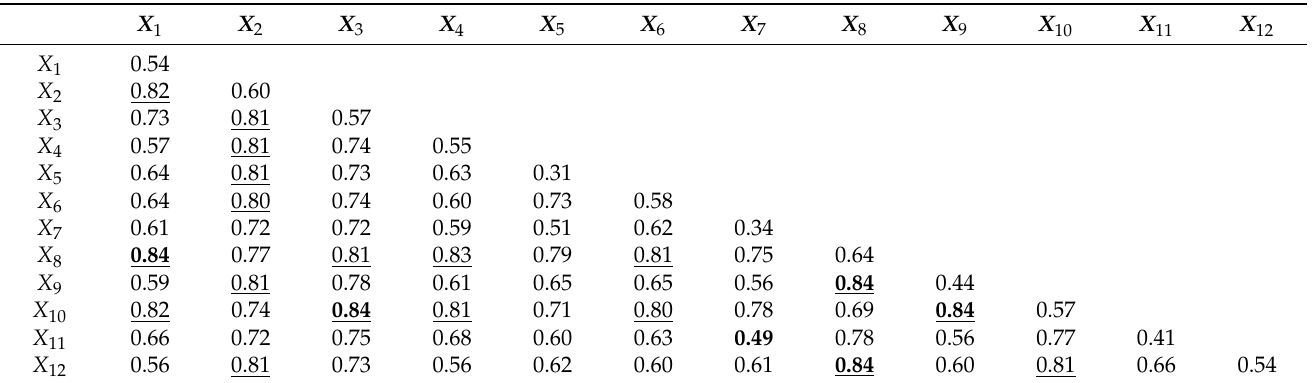
Table 7. Analysis of the evolution mode of independent variables in